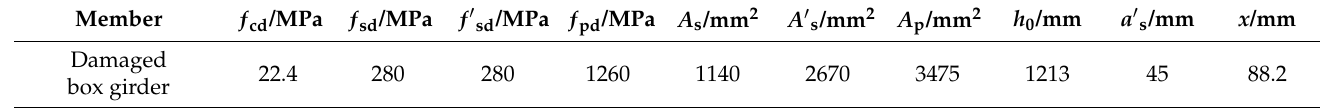
Table 8. Calculation parameters of normal section flexural capacity of the damaged box girder.